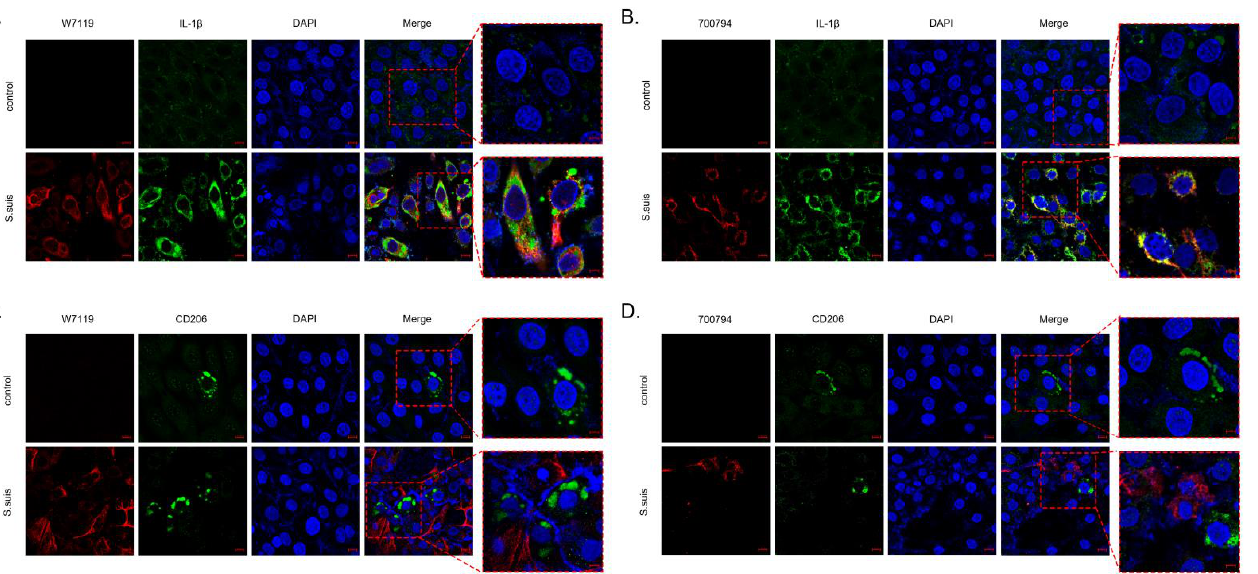
Figure 2. Cytotoxicity induced by S. suis infection. PAM-Tang cells were infected with S. suis vir- 700794 or S. suis avir-W7119 at MOI = 1 and incubated for 0.5, 1, 2, 3, 8, 12, or 24 h, negative control expressed as 0 h. The triangles represent S. suis W7119 infection group ( n = 3), diamonds represent S. suis 700794 infection group ( n = 3). Culture supernatants were measured for their LDH activity and expressed as optical density (OD 492 ). Each number represents the mean ± SD generated from three cell supernatants at each time point, and experiments were repeated three times. significance was determined using two-way ANOVA and Tukey’s multiple-comparison test; ns: not significant; *: p < 0.05; ***: p < 0.001.